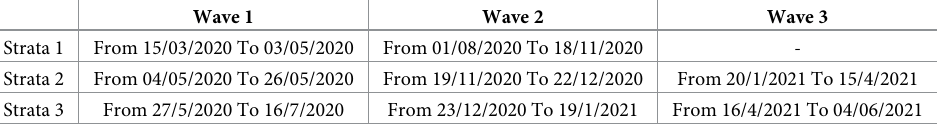
Table 2. Strata 1(small cases) strata 2 (medium cases) strata 3 (high cases) and the dates corresponding to three